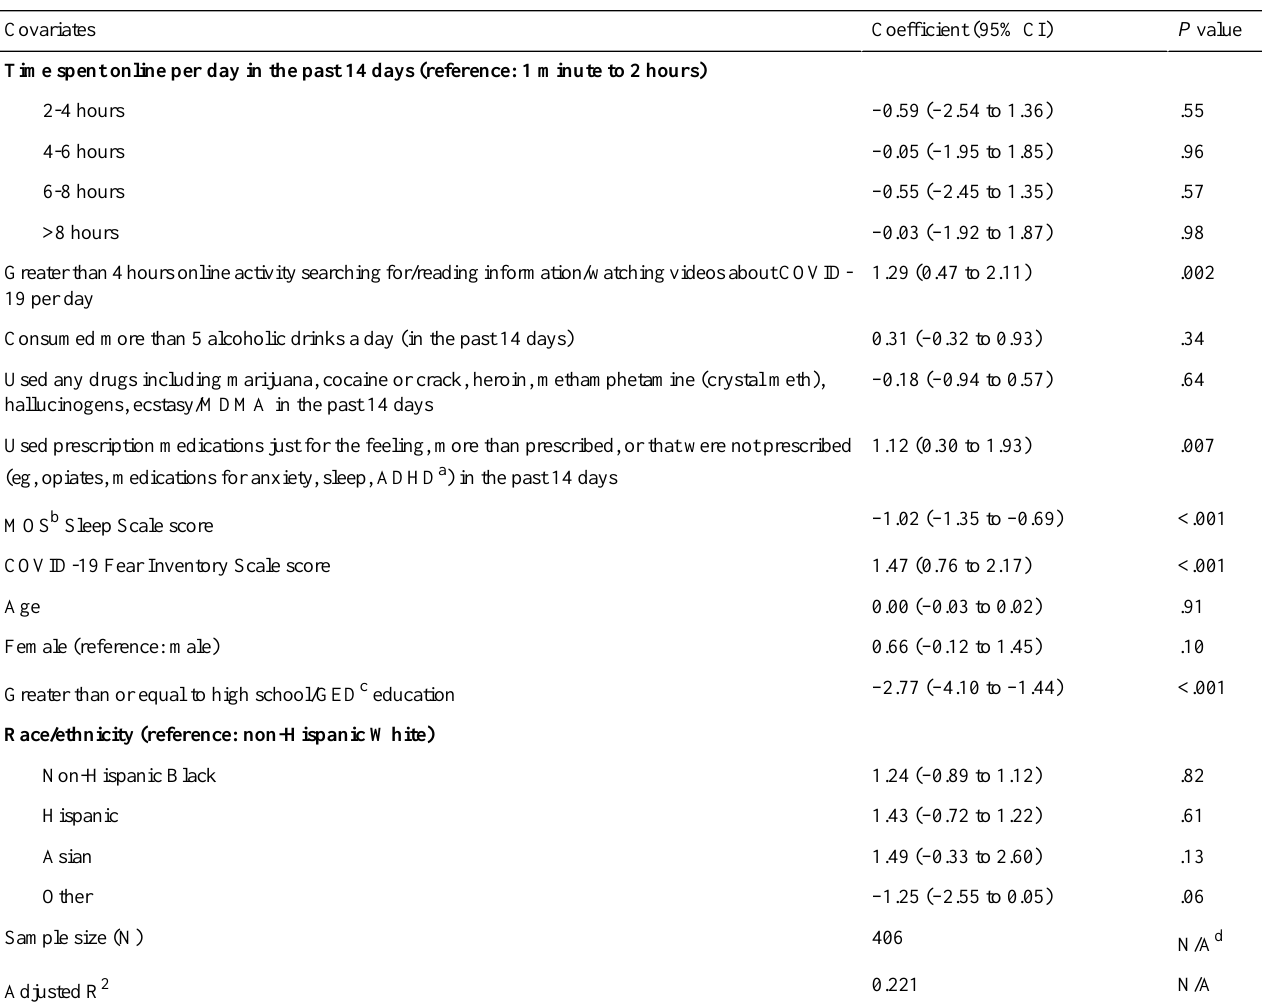
P valueCoefficient (95% CI)Covariates